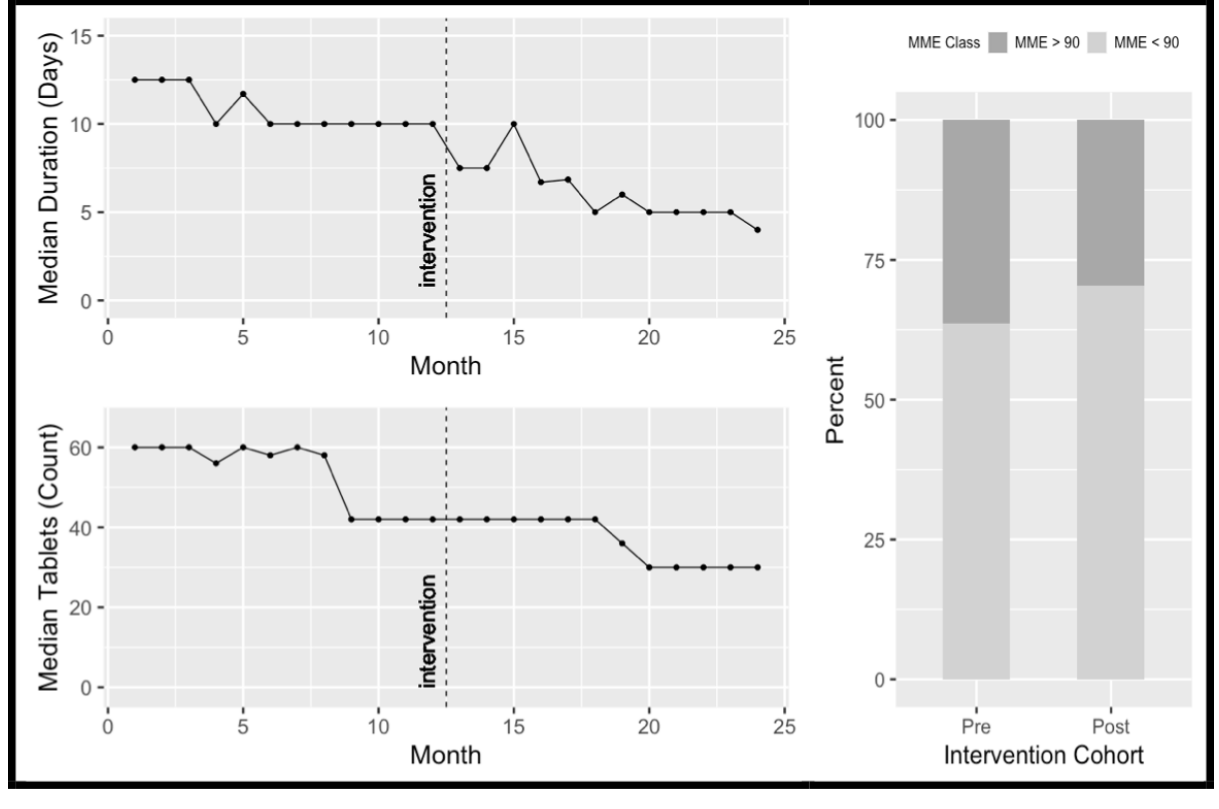
Figure 3. Monthly median number of tablets dispensed, median durations (days) of treatment and proportion of oxycodone prescriptions > 90 MME/day pre and post-intervention. MME: morphine milligram